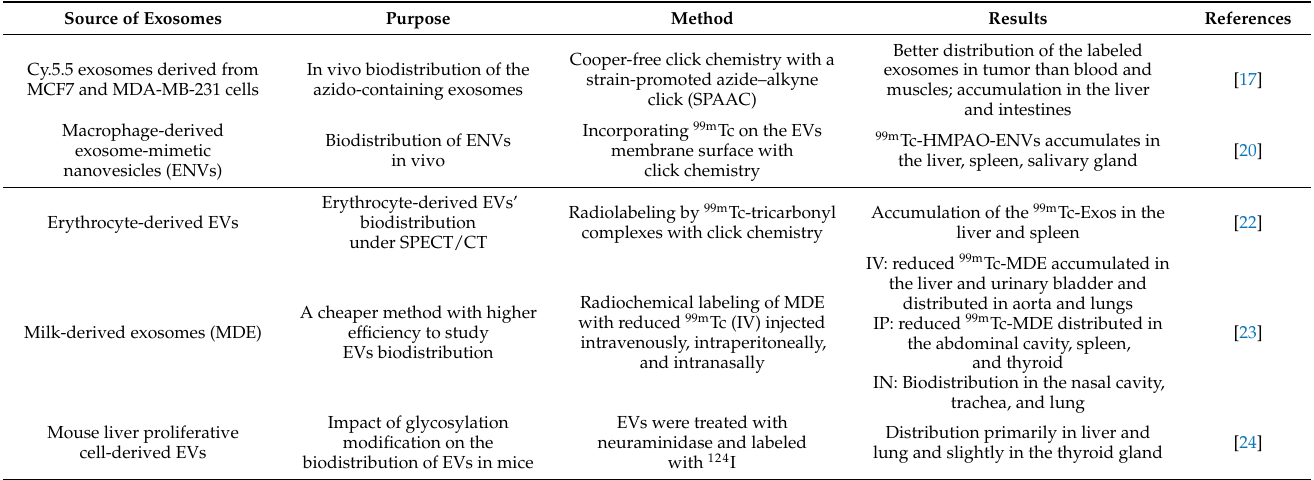
Table 1. Summary of the studies dealing with a chemical modification for in vivo tracking of extracellular vesicles using the covalent-binding method.